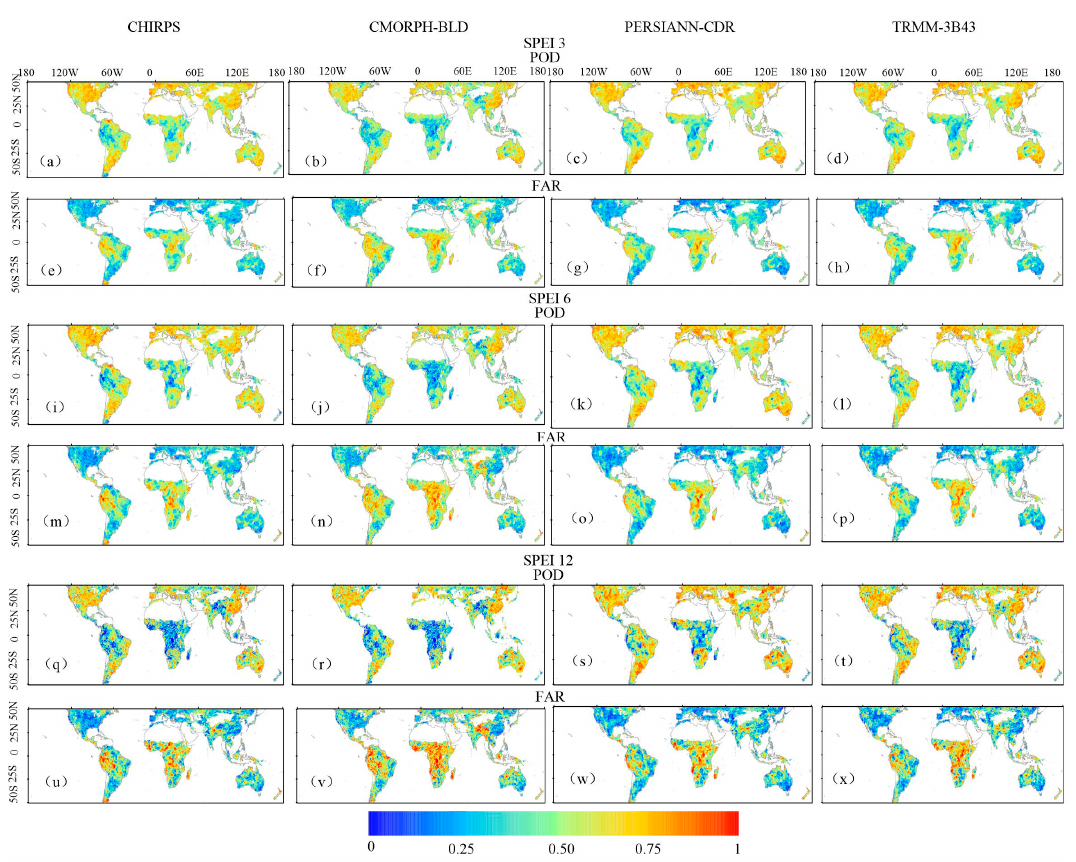
Figure 5. The POD and FAR of the 3-, 6-, and 12-month SPEI for each QPE product versus CRU product from 2000 to 2016 (the first and second rows represent the SPEI3, the third and fourth rows represent the SPEI6, and the fifth and sixth rows represent the SPEI12) ( a – x ).